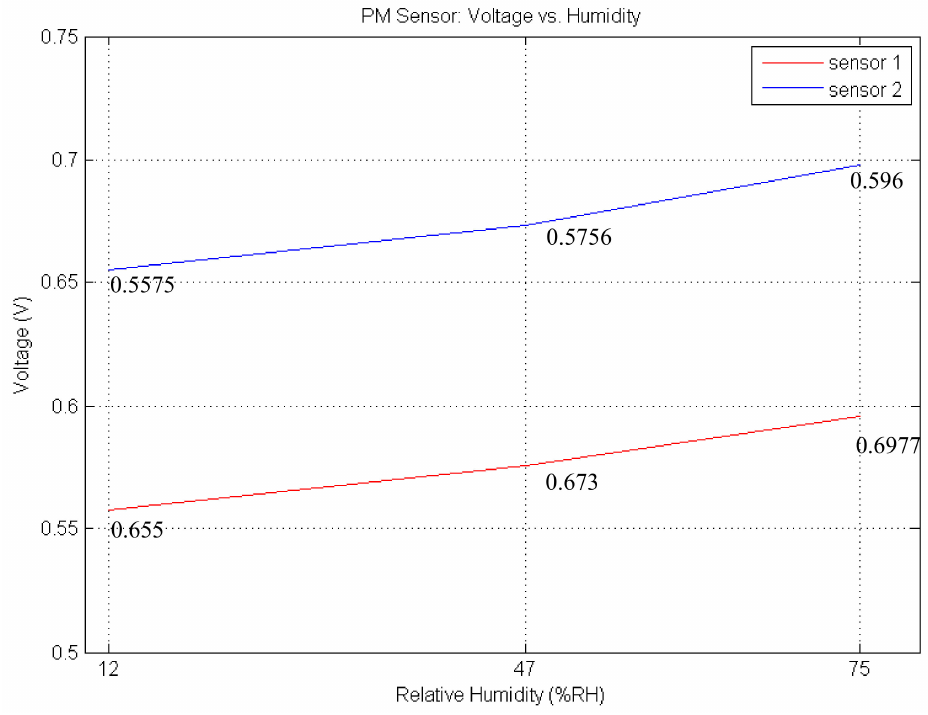
Figure 11. Offset according to